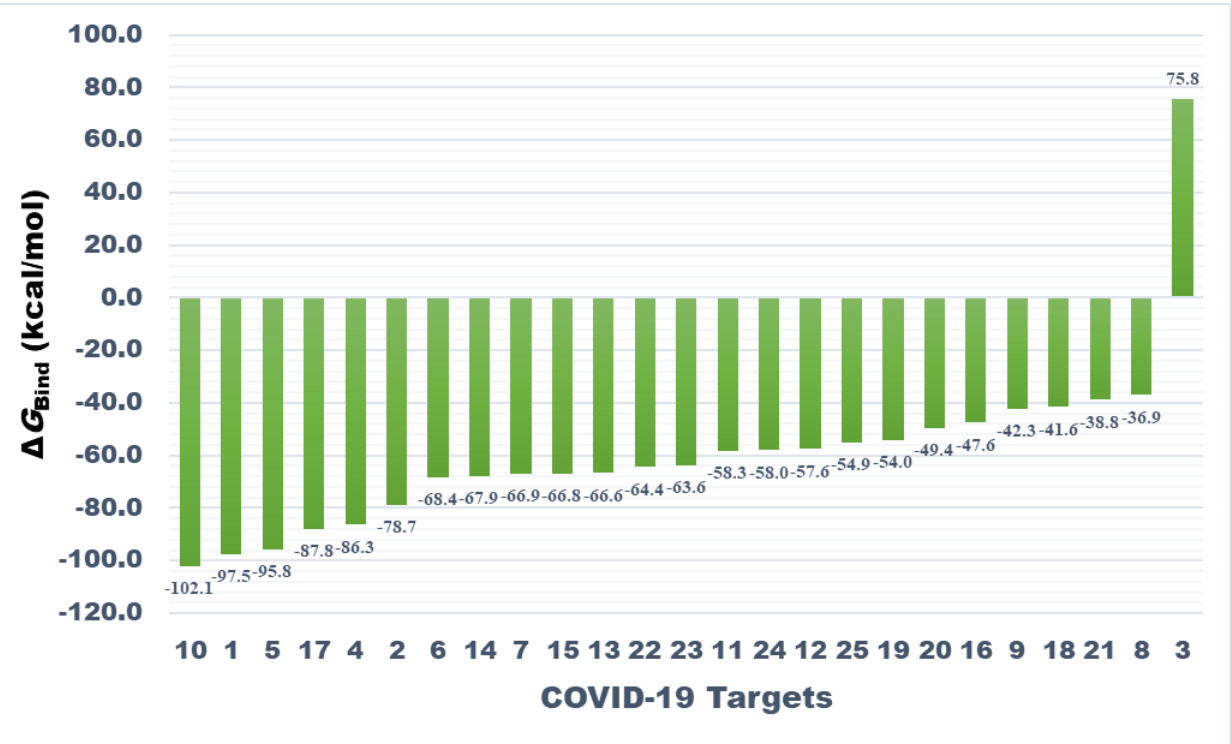
Figure 4. Bar plot showing comparative affinity of teicoplanin against drug targets associated with COVID-19 (please refer to Table 2 for target names against respective numbers). The analysis is based on molecular mechanics–generalized Born surface area (MM-GBSA) computed binding energy (Δ G Bind ) in kcal/mol.